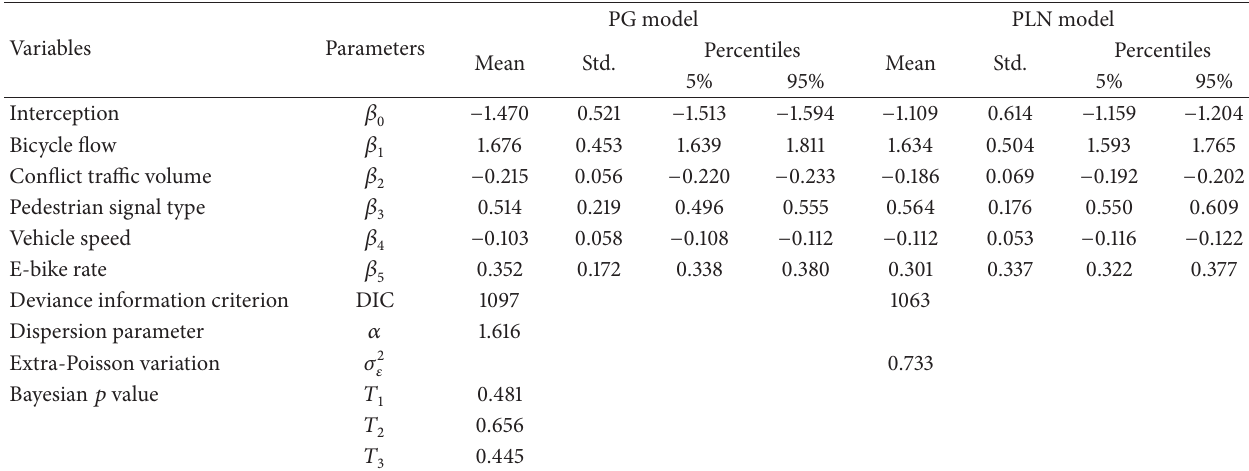
Table 2: Summary of model estimation